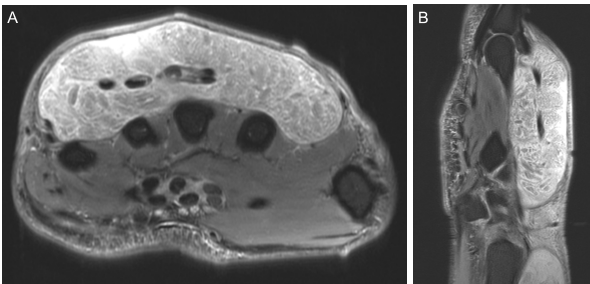
Figure 5. (a) Anteroposterior (AP) and (b) lateral radiographs of the patient’s right wrist and hand demonstrate no osseous changes secondary to osteomyelitis. Significant edema can be appreciated in the soft tissues of the hand and wrist on lateral imaging.